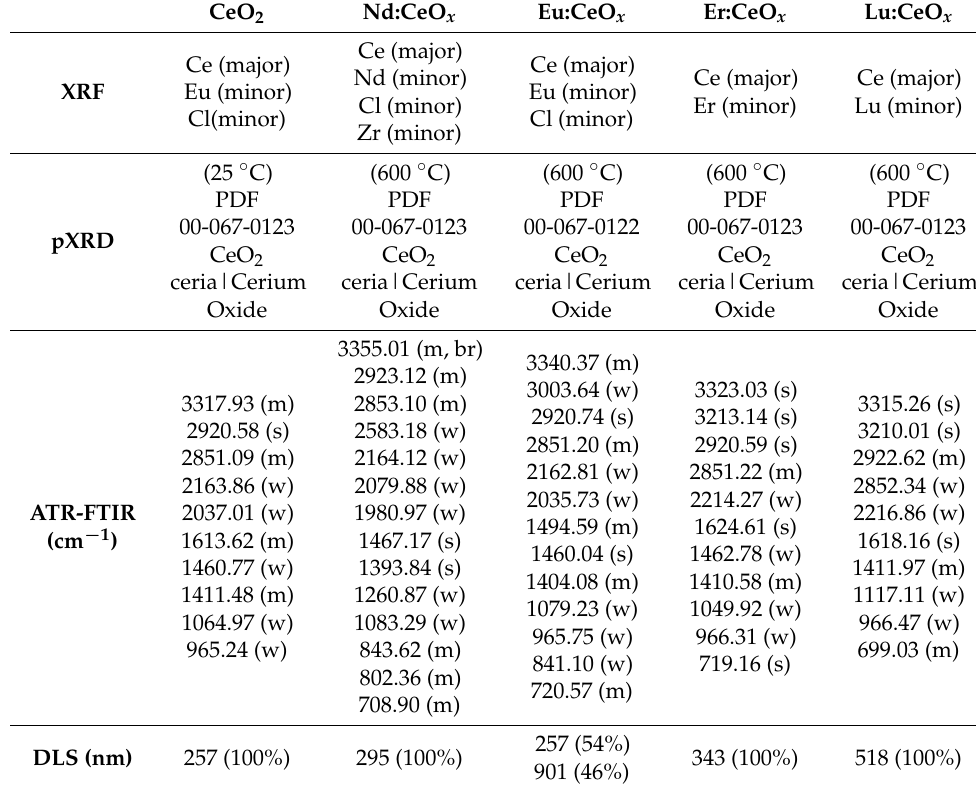
Table 1. Summarized results of XRF, pXRD, ATR-FTIR, and DLS for CeO 2 , Nd:CeO 2 , Eu:CeO 2 , Er:CeO 2 , and Lu:CeO 2 . The ATR-FTIR spectrum bends and stretches are further noted with medium (m), strong (s), weak (w), broad (br). Graphical representations of the data shown can be found in the Supplementary